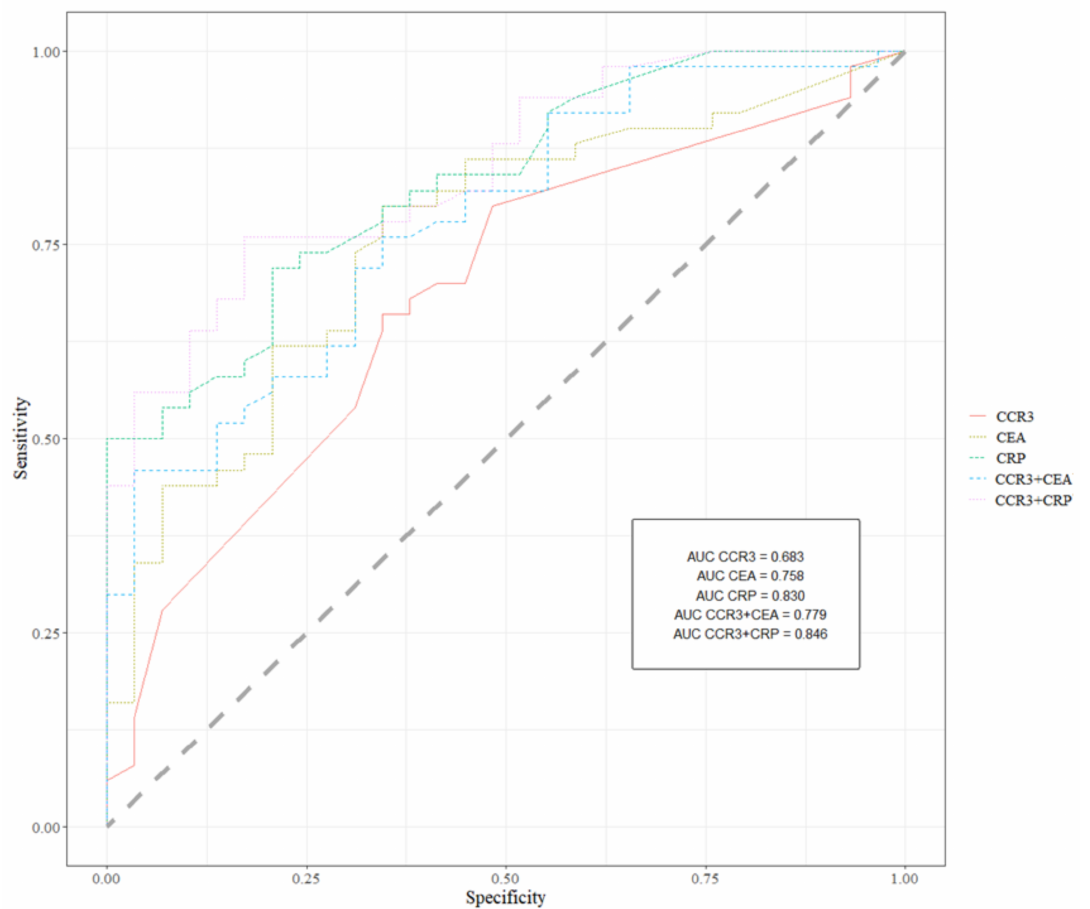
Figure 1. Receiver operating characteristics for all significant ROC analysis